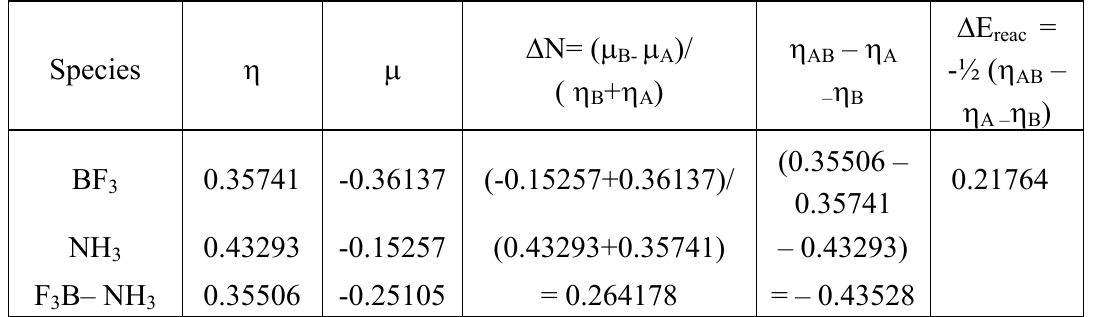
NH and F B–NH and 3, 3 3 3